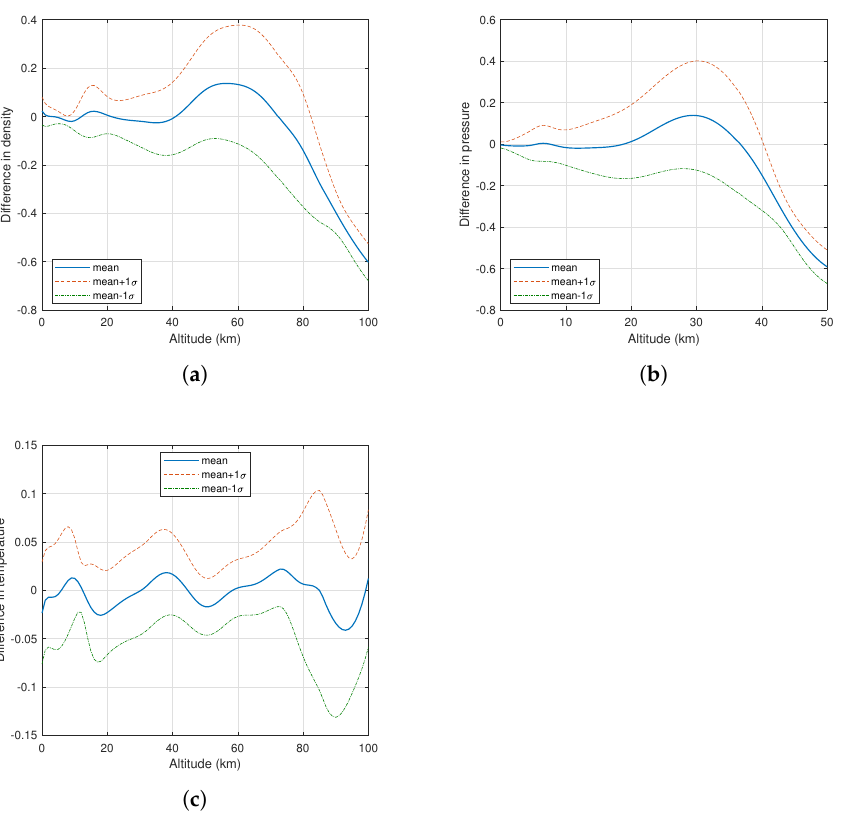
Figure 2. Mean and standard deviation ( ± 1 σ ) of the differences between every sample (representing an equivalent global static atmospheric model) and the US-76 model for each of the atmospheric parameters as a function of altitude. ( a ) Atmospheric density (kg/m 3 ); ( b ) Atmospheric pressure (kPa); ( c ) Atmospheric temperature